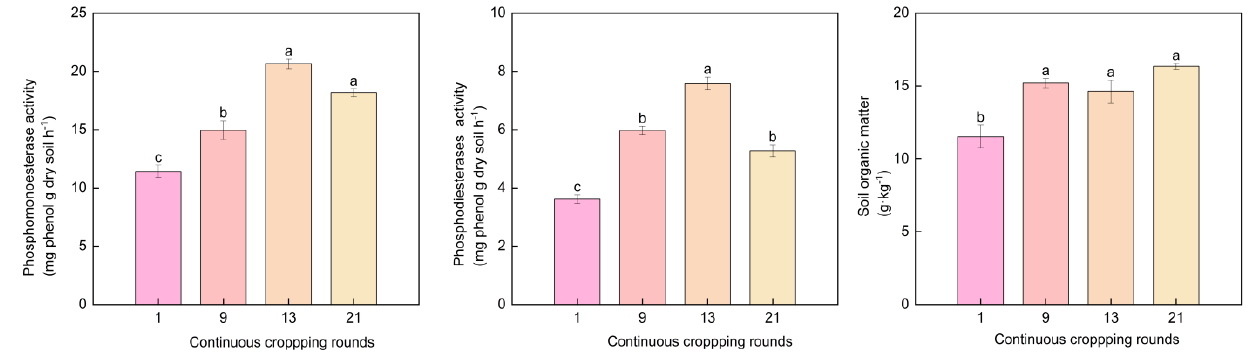
Figure 5. Effects of different continuous cropping rounds on soil phosphomonoesterase, phosphodi-